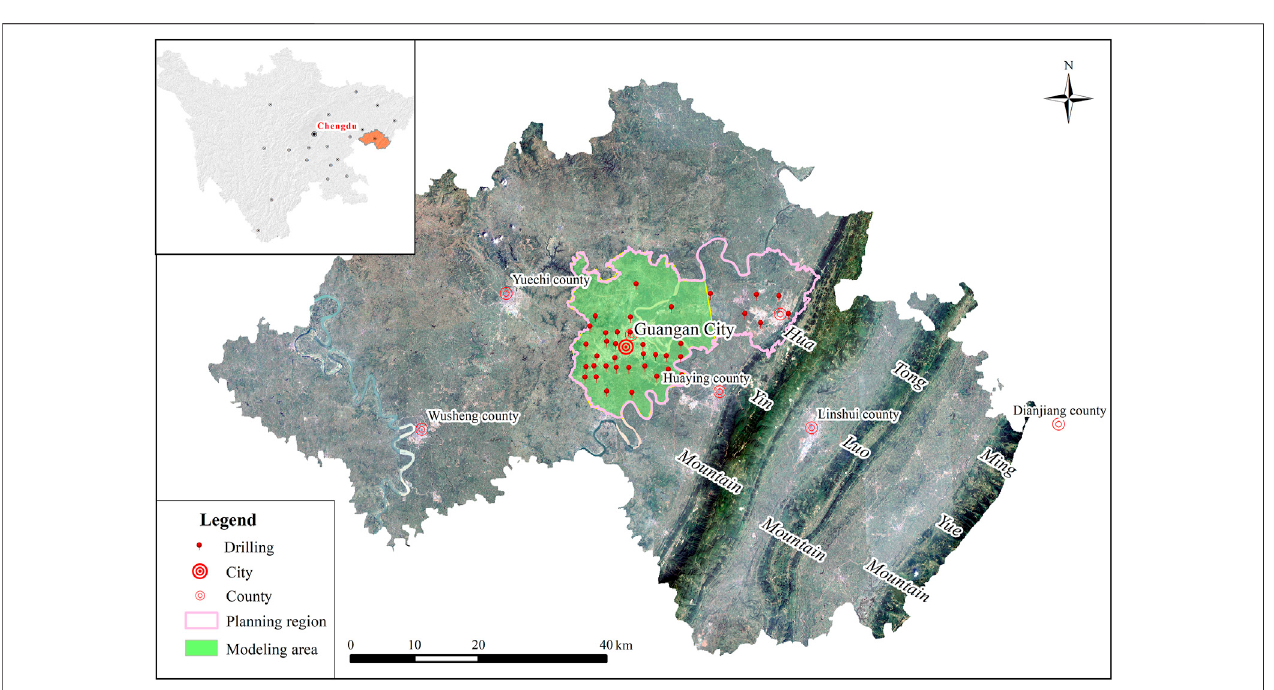
FIGURE 1 | Location of Guang ’ an city and the modeling